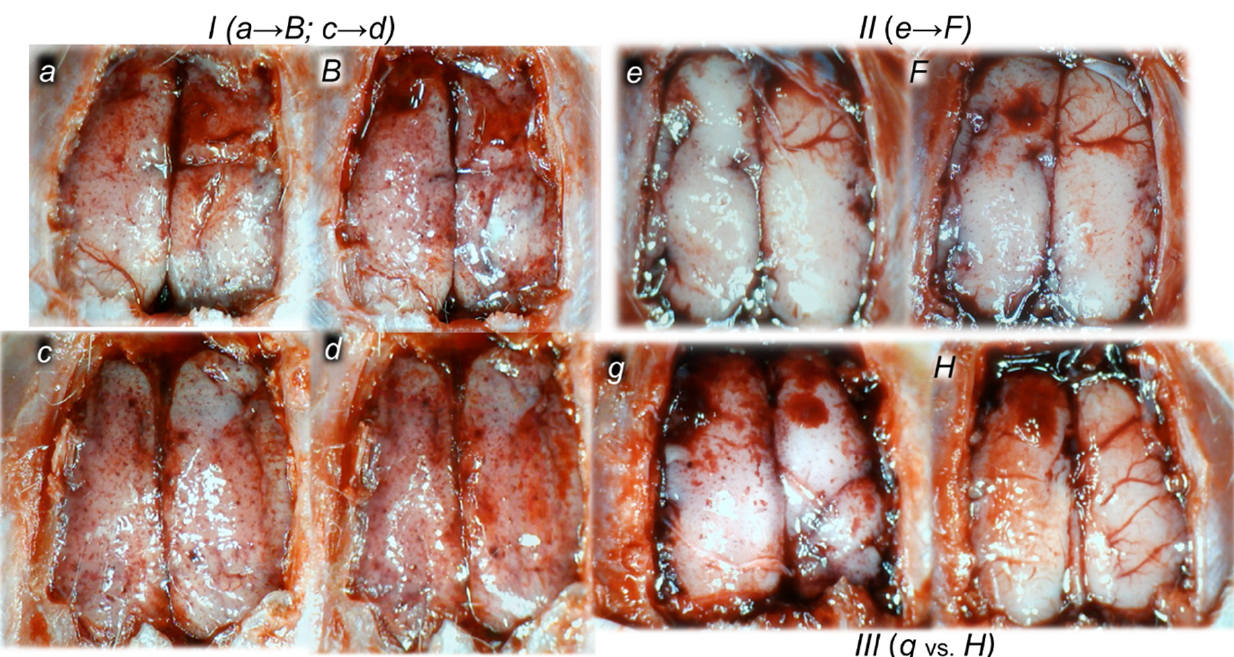
Figure 14. Gross presentation of the brain changes in rats with obstructed bile duct ( a – H ). Swollen brain ( a , c – e , g ) and brain swelling (saline application ( d , g )), but counteracted by BPC 157 therapy ( B , F , H ) in rats with obstructed bile duct. I. Swollen brain before medication (( a , c ) (immediate ligation-time)) and BPC 157 10 ng/kg intragastric administration, given immediately, ligation time 0, and effect assessed immediately thereafter; ( B ) the effect of the saline intragastric administration ( d ) assessed immediately ( d ) (worsened swelling due to uninterrupted progress of the injurious course). II. Swollen brain before medication ( e ) (4.30 h ligation time) and BPC 157 10 ng/kg intragastric administration, given at 4.30 h ligation time 0, and effect assessed immediately thereafter ( F ). III. Swollen brain ( g ) at 24 h ligation time, 24 h after saline (intragastric administration) given immediately after ligation. Swelling counteraction by BPC 157 therapy ( H ) at 24 h ligation time; BPC 157 10 ng/kg intragastric administration given at ligation time 0.